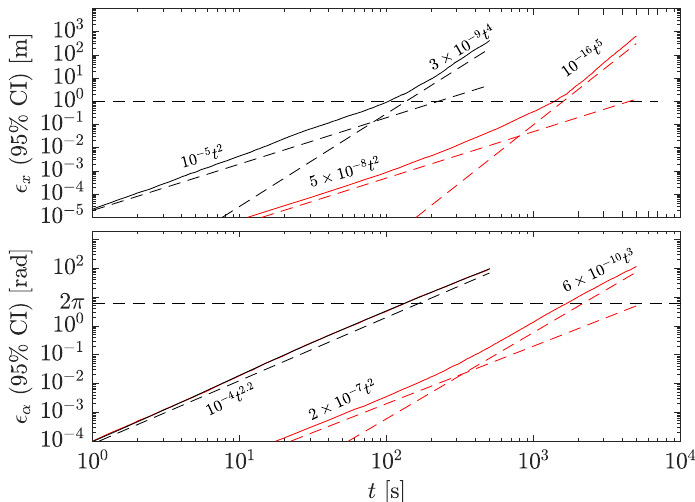
Figure 9. Uncertainty (95% probability) as a function of time in position ( top ) and orientation ( bottom ) for the HF (black) and LF (red) GF-INSs. Dashed lines indicate 1m and 2 π rad errors and are used as